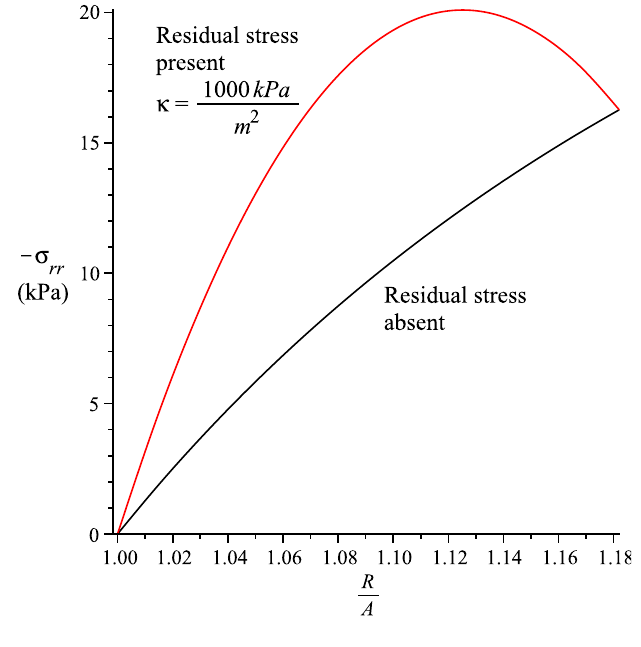
Figure 4. Radial stress for spherically symmetric deformation of a spherical shell. R b